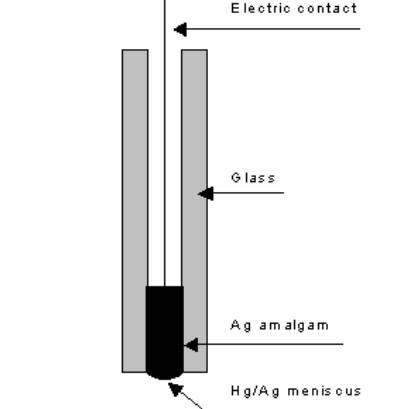
Figure 1. Meniscus-modified silver solid amalgam electrode